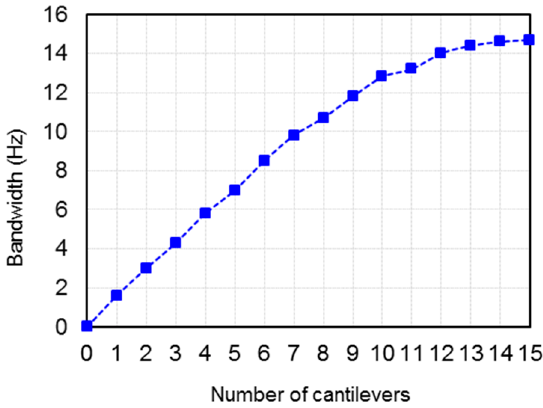
Figure 8. Simulation of bandwidth dependence on the number of cantilevers for ∆ f = 1.5 Hz. The lines